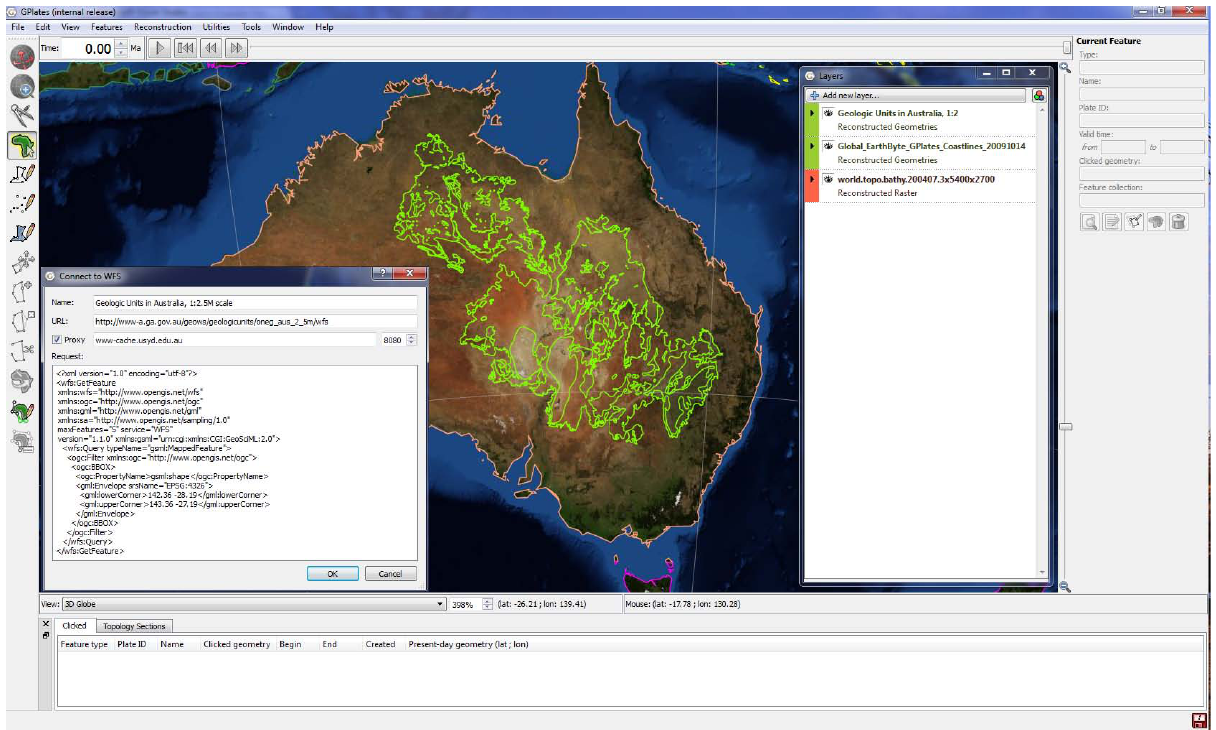
Fig. 33. Screenshot showing GPlates displaying geometries (green) defined in GeoSciML data, which is retrieved by Web Feature Service (WFS) from a Geosciences Australia website. The service base URL is http://www-a.ga.gov.au/geows/geologicunits/oneg aus 2 5m/wfs. The WFS request is shown in the dialog (left). All GPlates layers are listed in the dialog (right).